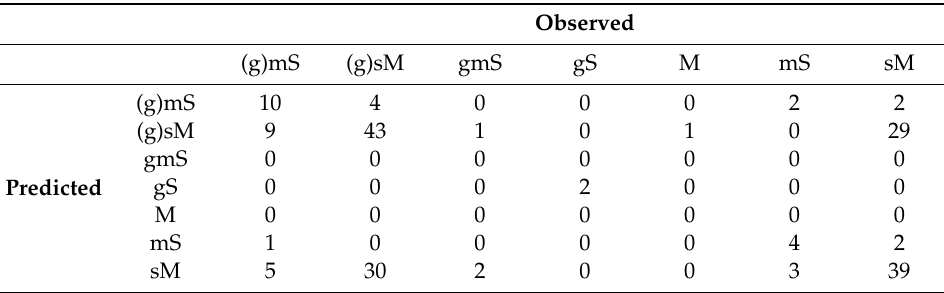
Table A1. Categorical Folk LOO CV error